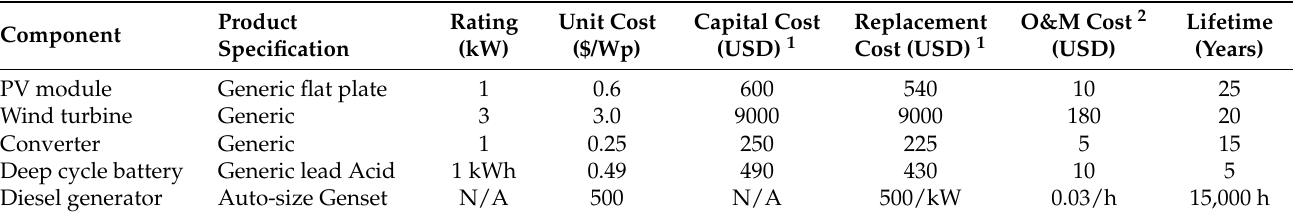
Table 6. Ratings and costs for various system components used in the